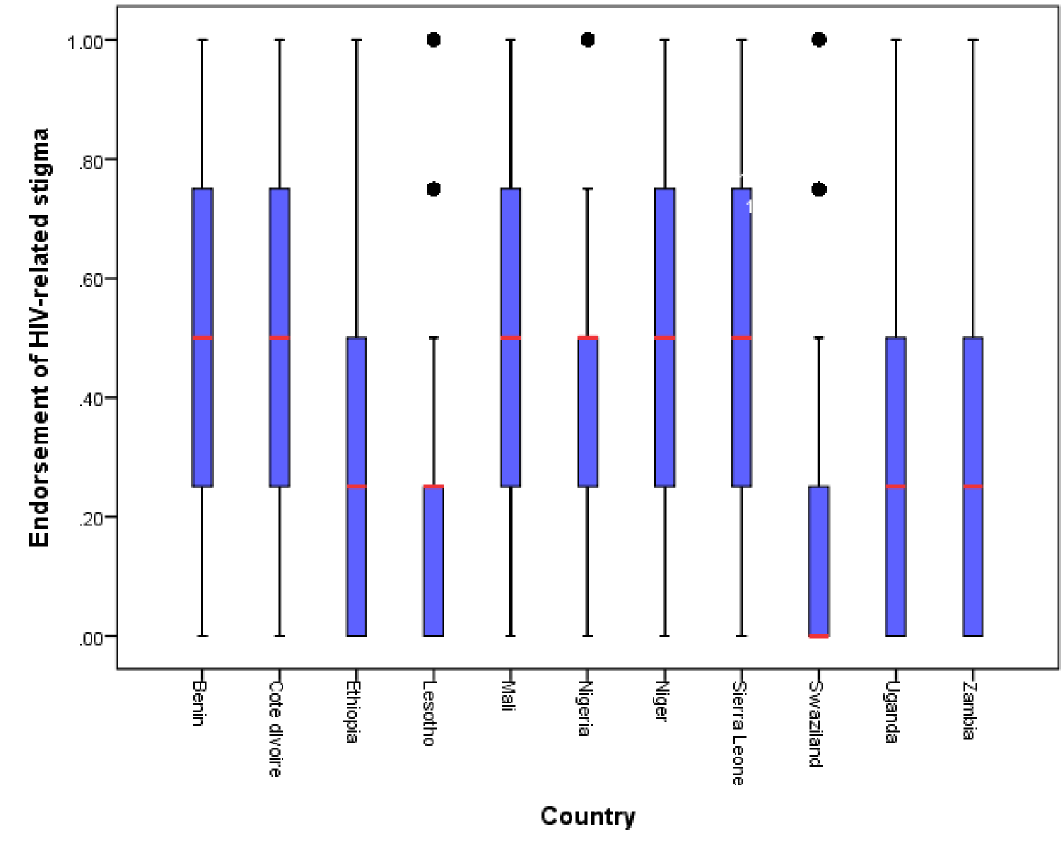
Figure 2. Level of HIV-related stigma endorsement in 11 sub-Saharan African countries.